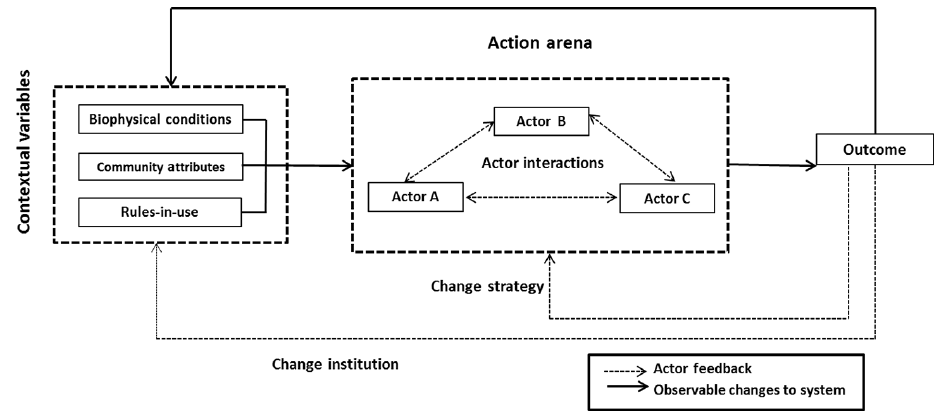
Figure 1. IAD Framework (adapted from Ostrom,